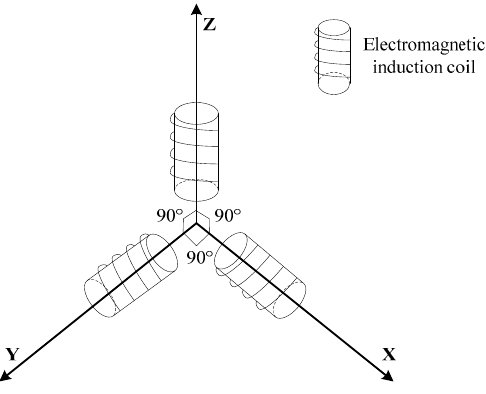
Figure 4. Schematic diagram of installation method of triaxial coils.